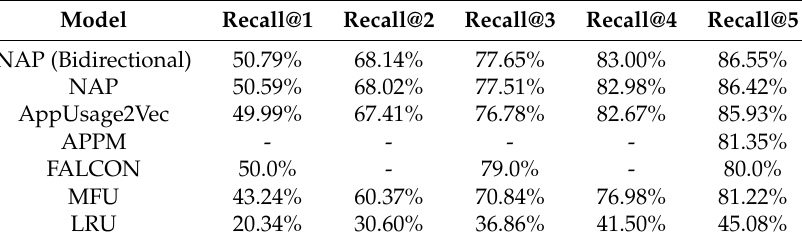
Figure 7. Recall@k performance for NAP, LRU and MFU. Table 2. Best month Recall@k results for each